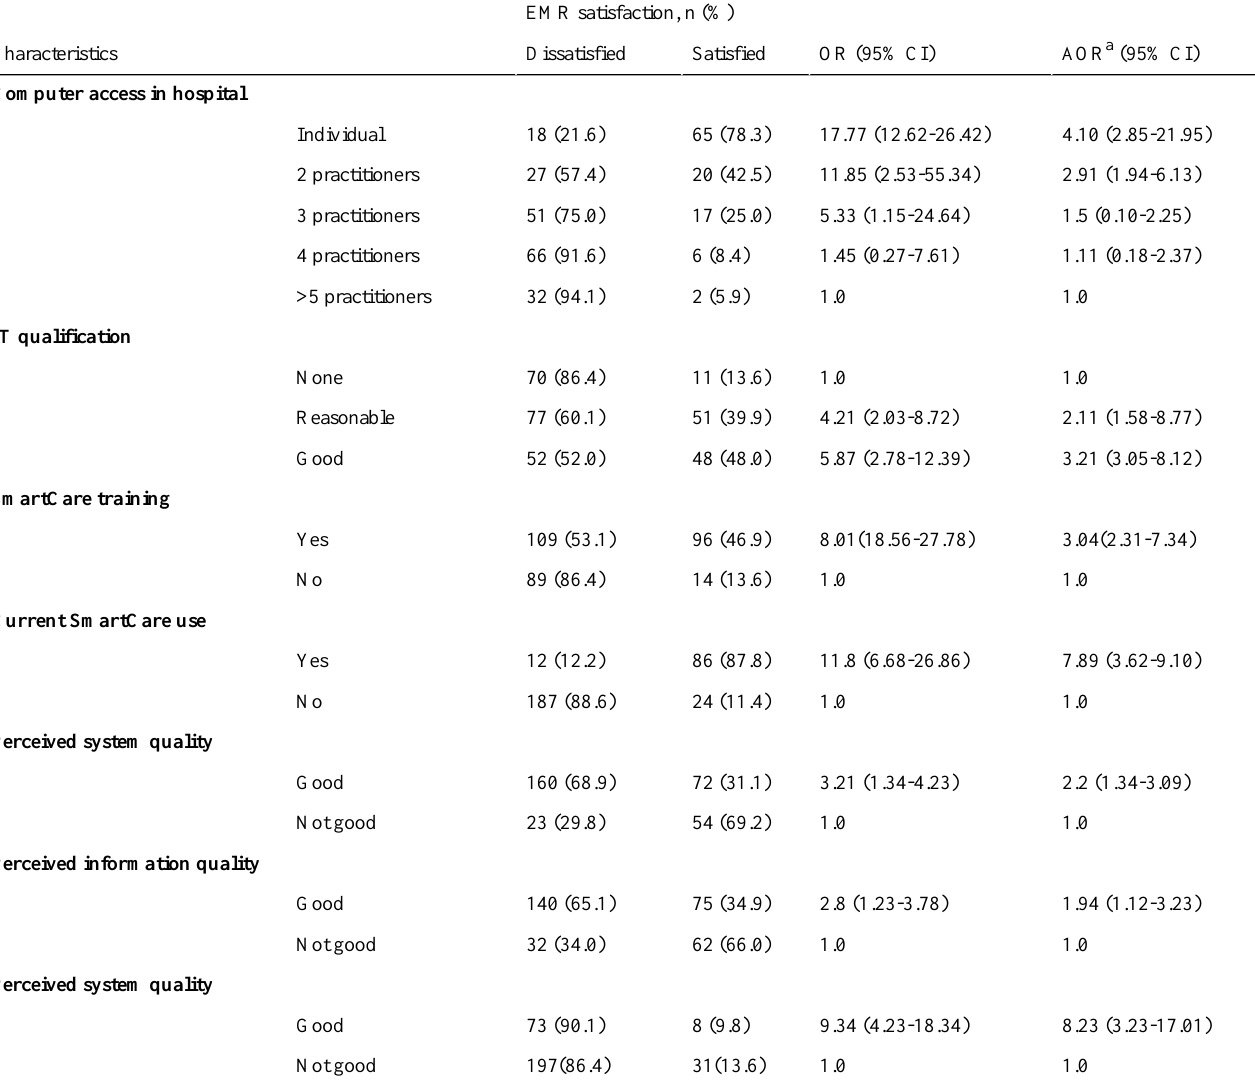
Table 7. Binary logistic regression analysis of factors associated with EMR satisfaction with a 95% CI and a significance level of P <.05